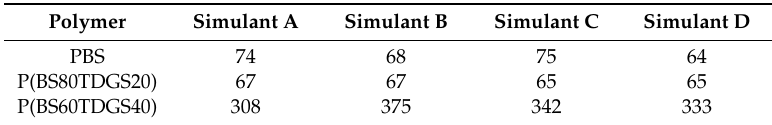
Table 4. Residual ∆ H m (%) after the treatment with food simulants.